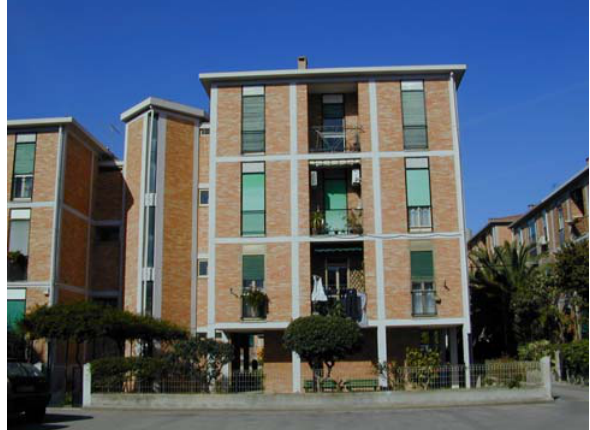
Figure 2. The current state of the buildings in the “La Palma” district.